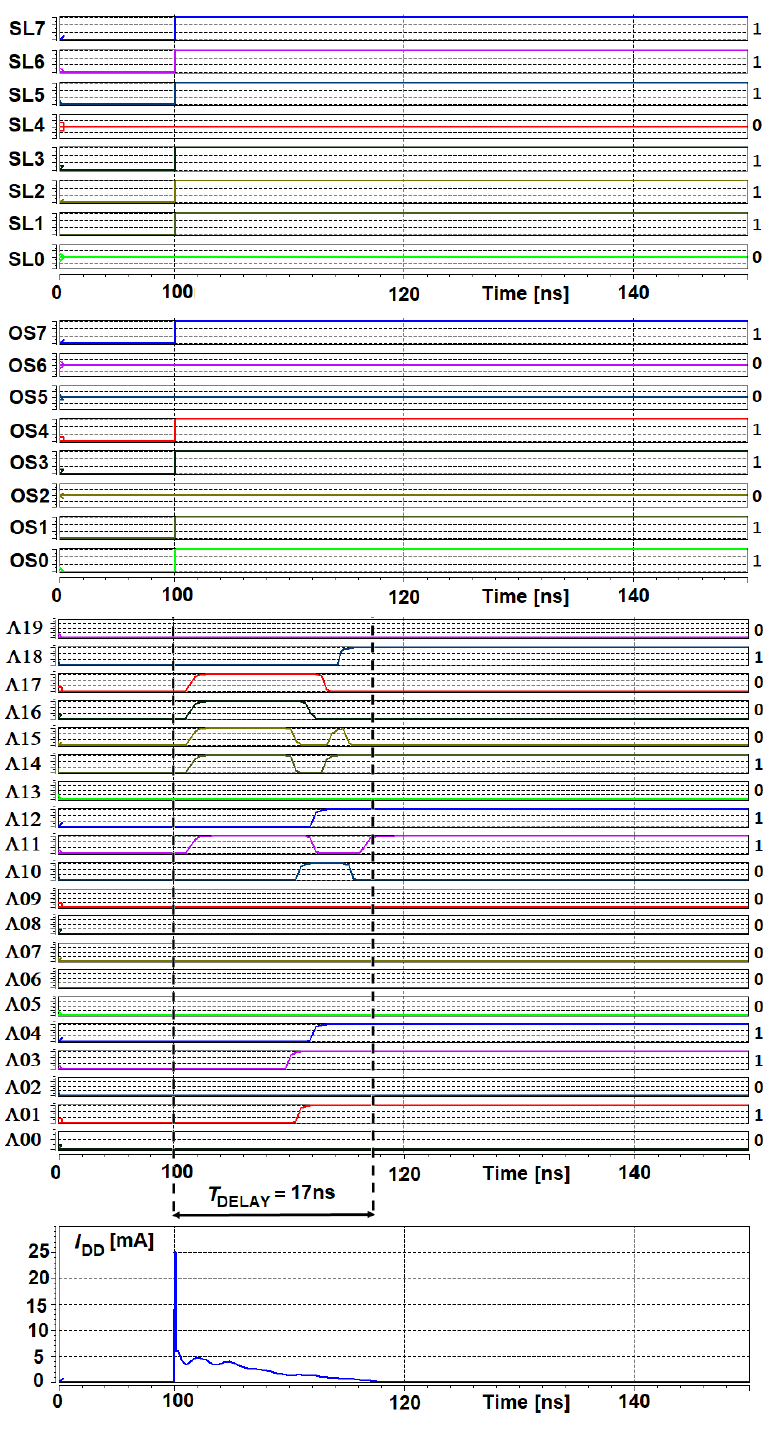
Figure 9. Selected transistor-level results illustrating the behavior of the proposed approximation circuit, shown in Figure 4. The results are shown for a selected value of the s signal of